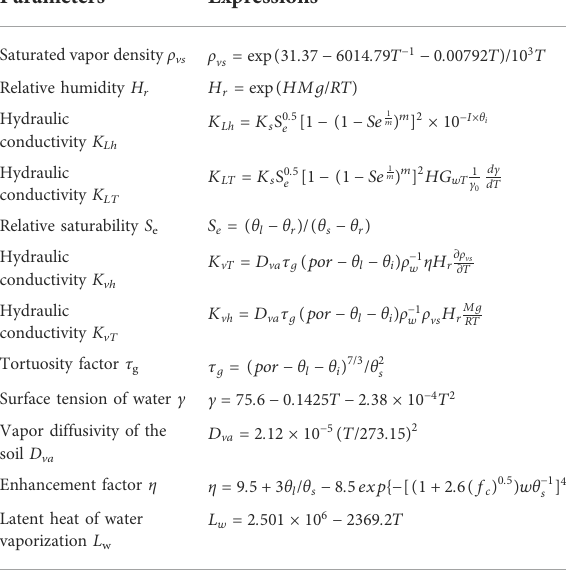
TABLE 2 Expressions for related parameters.